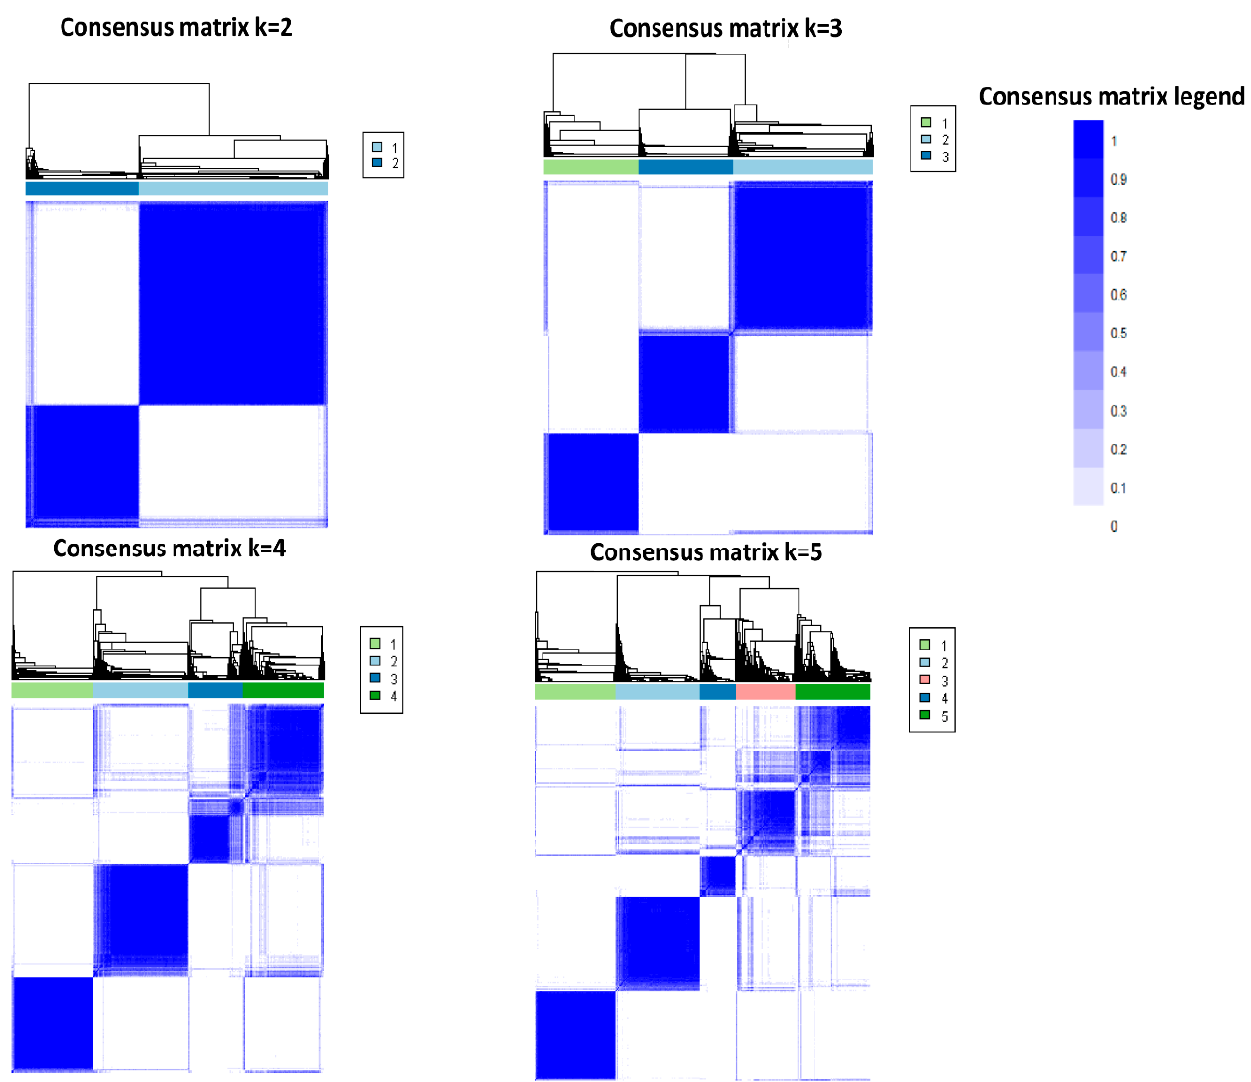
Figure 2. Consensus matrix heat map depicting consensus values on a white to blue color scale of each cluster. The mean cluster consensus score was comparable between a scenario of two or three clusters (Figure 3A). In addition, favorable low PACs by both strict and relaxed criteria were demonstrated for three clusters (Figure 3B). Thus, using baseline variables at hospi- tal admission, the consensus clustering analysis identified three clusters that best repre- sented the data pattern of our ICU patients with lactic acidosis.